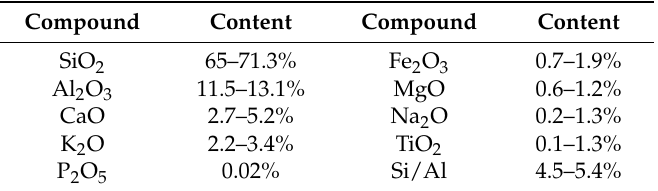
Table 1. Clinoptilolite chemical composition [25].